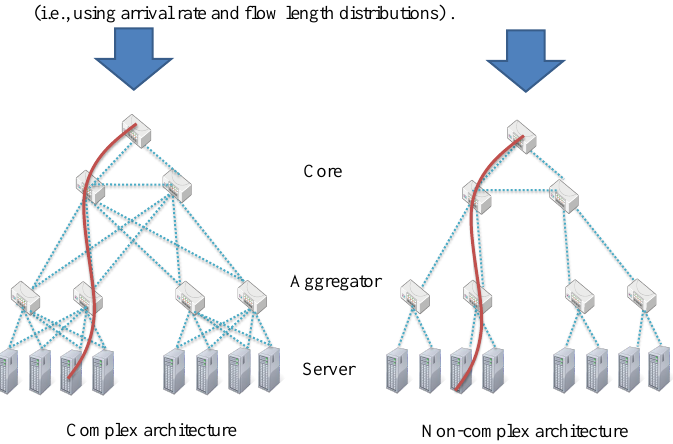
Figure 6. An illustration of the evaluation environment. In this evaluation scenario, Clients’ TCP flows arrive at both data center, whose traffic volume depends on the arrival rate and flow length distributions.